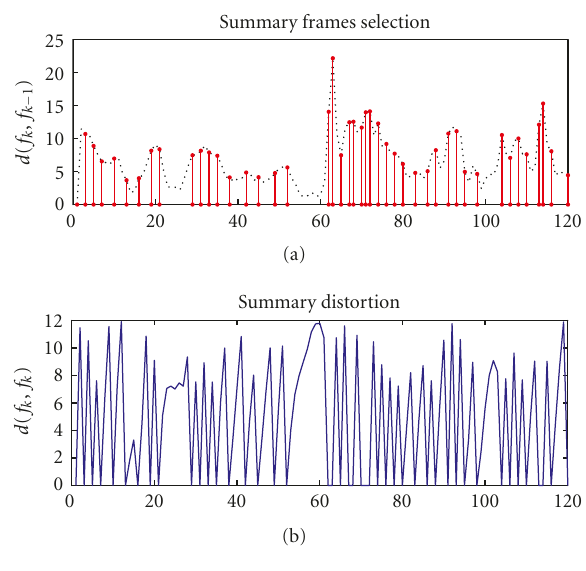
Figure 4: MEOS summary example.